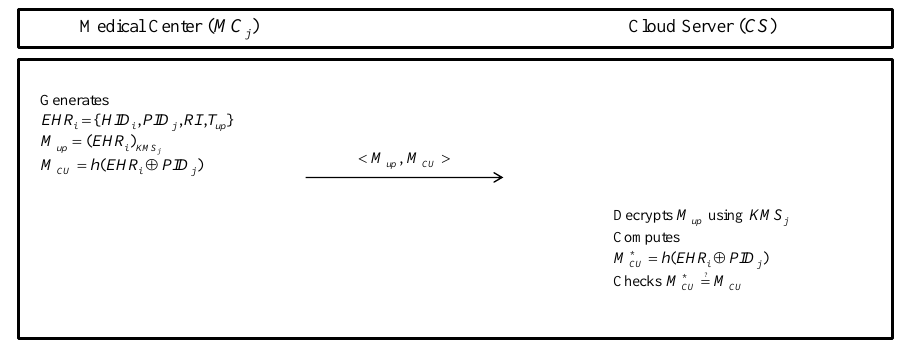
Figure 6. EHR storing phase of the proposed